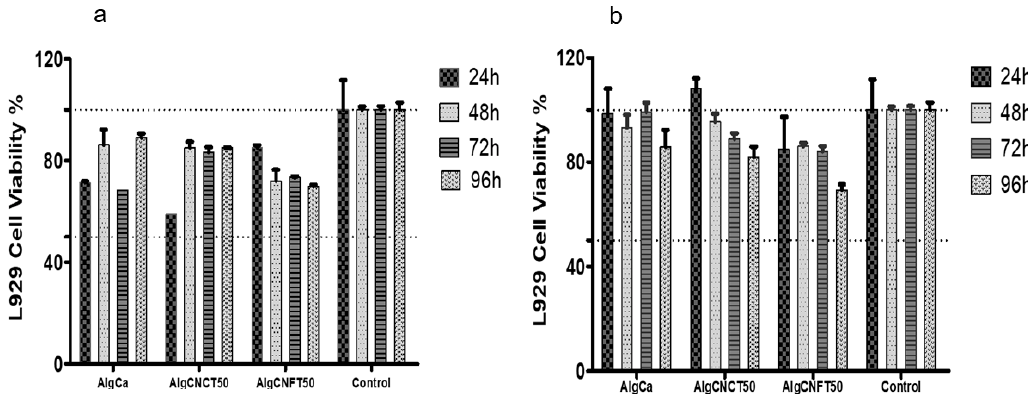
Figure 6. L929-fibroblast cells 3-(4,5-dimethylthiazolyl-2)-2,5-diphenyltetrazolium bromide (MTT) assays. ( a ) Direct contact assay cytotoxicity and cell proliferation were evaluated for 24, 48, 72, and 96 h. ( b ) Indirect contact assay (eluate for 48 h) cytotoxicity and cell proliferation were evaluated for 24, 48, 72, and 96 h. Data represent the mean ± standard deviation of six replicates for each material ( n = 6).